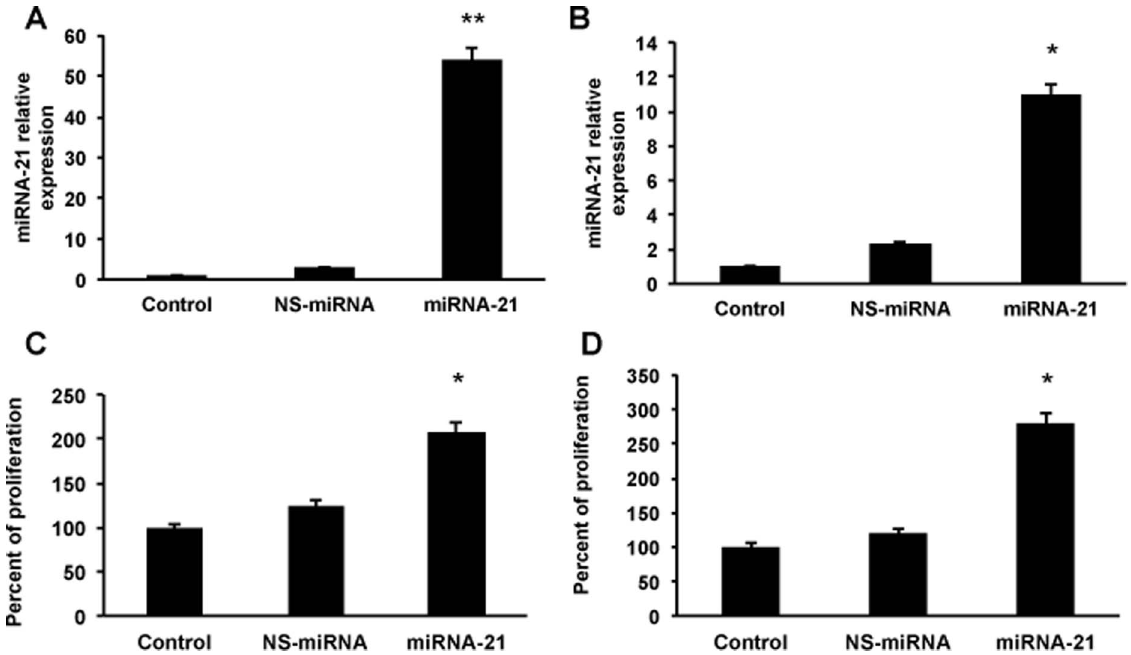
Figure 4. Role of miRNA-21 on proliferation of hepatoma cells. miRNA-21 was over-expressed in Hep G2 (A & C) and Huh 7 (B & D) cells. Relative expression of miRNA-21 was measured in the transfected cells (A & B) to determine the miRNA-21 levels (n=3; *p , 0.05 and **p , 0.01). As an internal control, 5S RNA was quantified in all real time PCR experiments. Both C & D show the cell proliferation assays in miRNA-21 over-expressing cells. Cells were plated at a density of 8000/well in a 96-well plate for the proliferation assays. As a control in all these experiments NS-miRNA was used in parallel experiments (n=3; *p , 0.05).